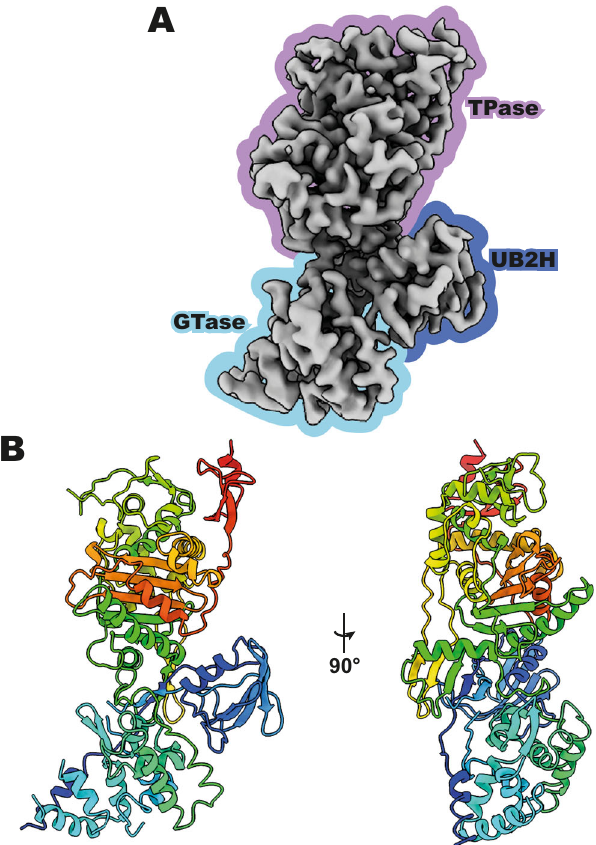
Fig. 1 CryoEM structure of apo E. coli PBP1b. A Reconstruction of apo PBP1b at 3.28 Å resolution with GTase (glycosyltransferase), TPase (transpeptidase) and UB2H (putative activator binding) domains labelled. B Re fi ned structure of apo PBP1b in ribbon representation and rainbow colouring from N to C terminus (blue to